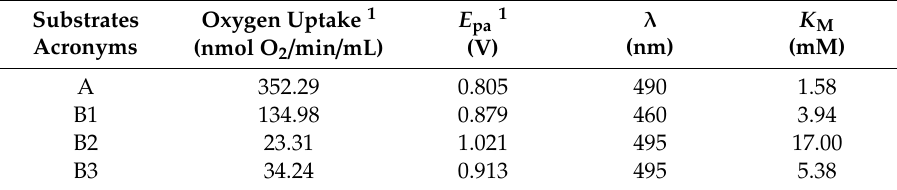
Table 1. Electrochemical and kinetic parameters of tested substrates.